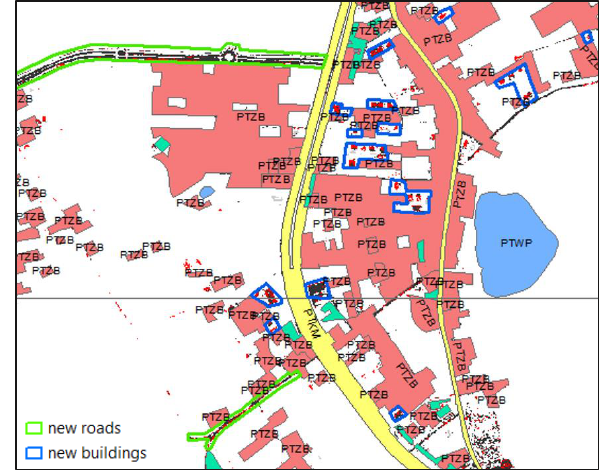
Figure 12. Classes presenting grey infrastructure according to TD class names and the indication of places to update (blue and green lines). Land cover classes are: PTZB – build-up area, PTKM – transport area, PTWP – water area.